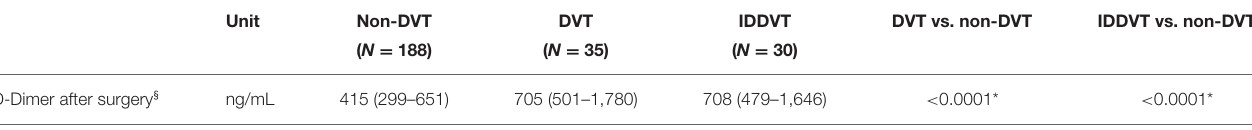
TABLE 3 | Comparison of post-surgical D-Dimer between DVT, IDDVT, and non-DVT cases among total cancer patients ( N = 223). Unit